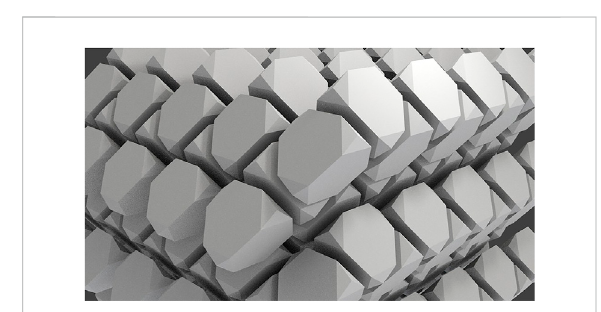
FIGURE 3 Tightly packed truncated tetrahedrons fi ll space